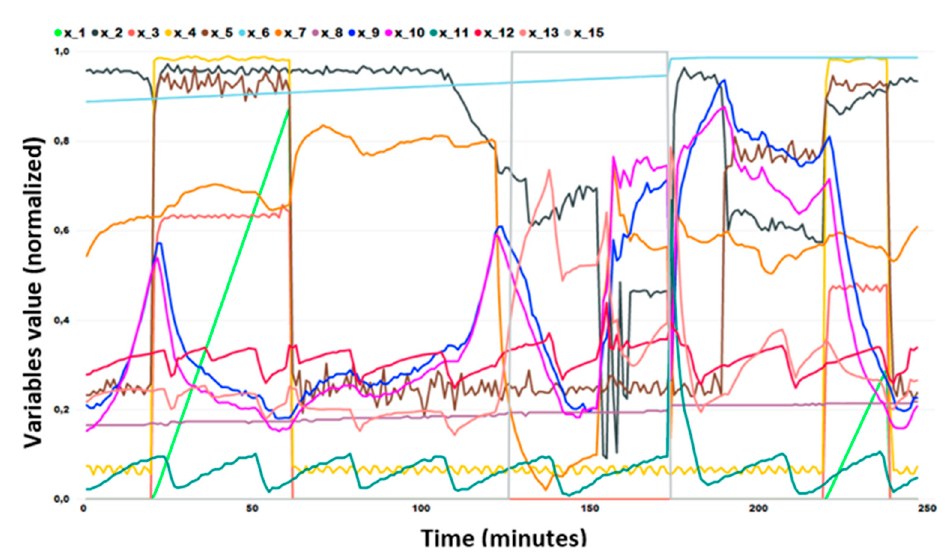
Figure 2. Run chart of the 15 parameters during a complete production cycle.